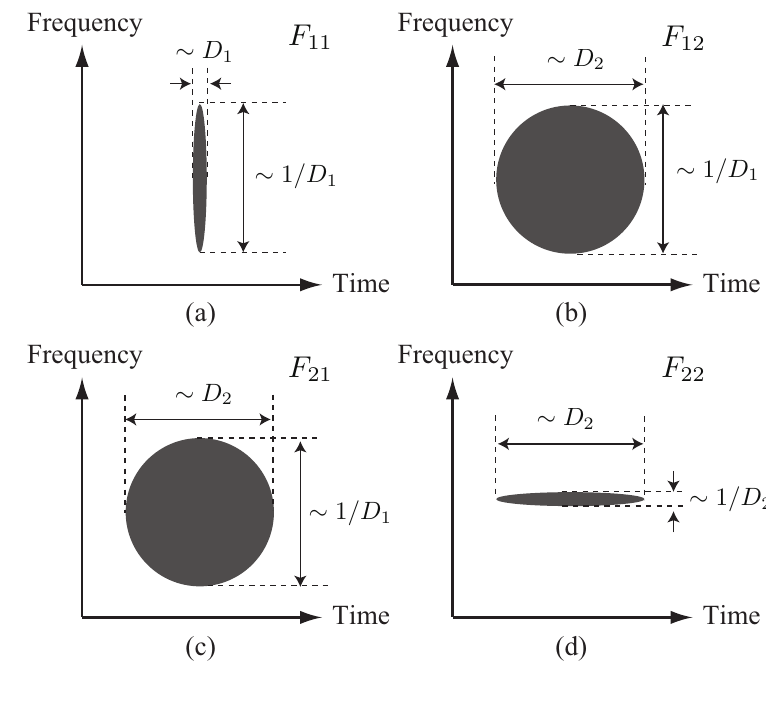
, k, l = 1 , 2 spreadness. kl ; ( b ) F ; ( c ) F ; and ( d ) F 11 12 21